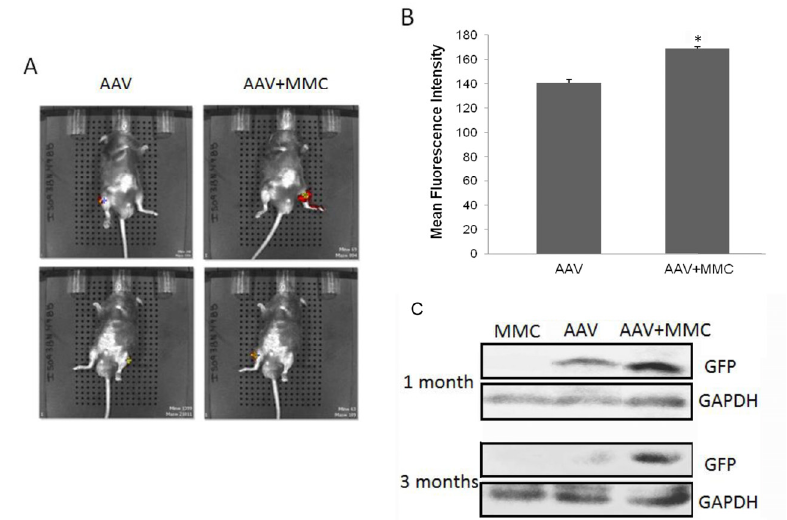
Figure 4. MMC improves rAAV-mediated gene expression in mice. ( A ) In vivo optical imaging at 1 month post-infection. (Upper panel) Right leg infected with rAAV (2 × 10 10 Gps), left leg infected with rAAV (2 × 10 10 Gps) mixed with MMC (1 μ g/kg); (Lower panel) Left leg infected with rAAV (2 × 10 10 Gps), right leg infected with rAAV (2 × 10 10 Gps) mixed with MMC (1 μ g/kg); ( B ) Assay of mean fluorescence intensity for in vivo optical imaging ( * p < 0.05); and ( C ) Western blot analysis for the GFP expression mediated by rAAV with or without MMC in muscle injection model. The levels of GAPDH expression served as internal